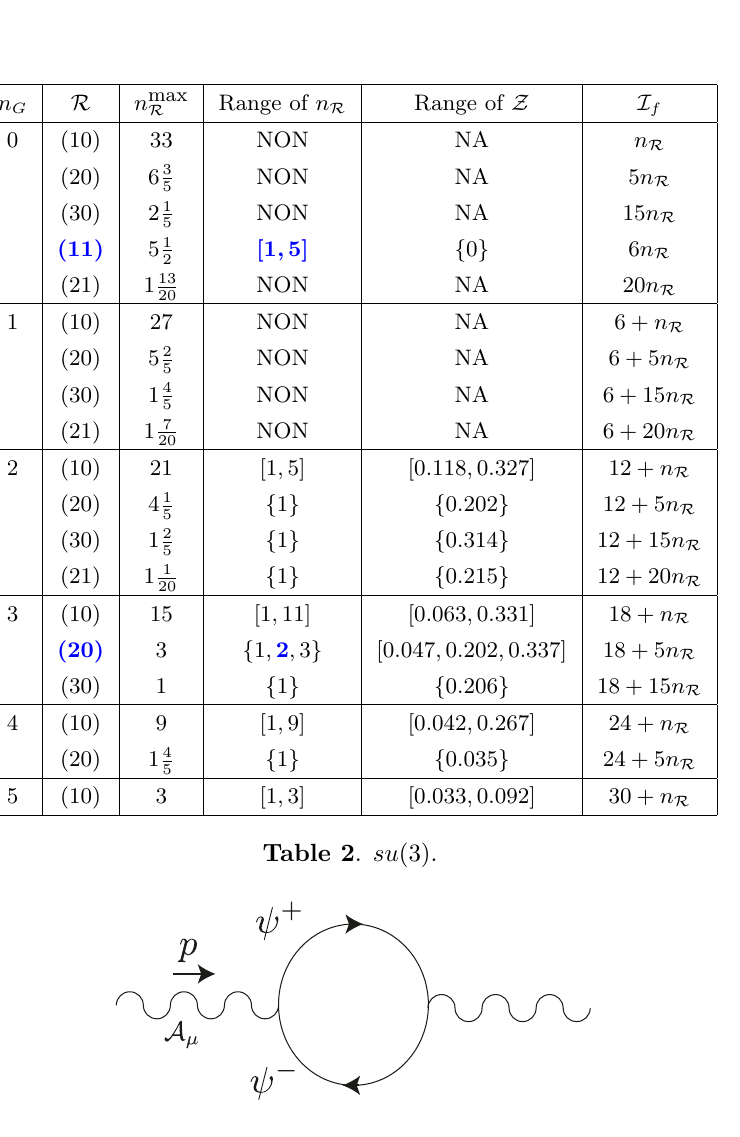
Figure 3 . Fermion contribution to the vacuum